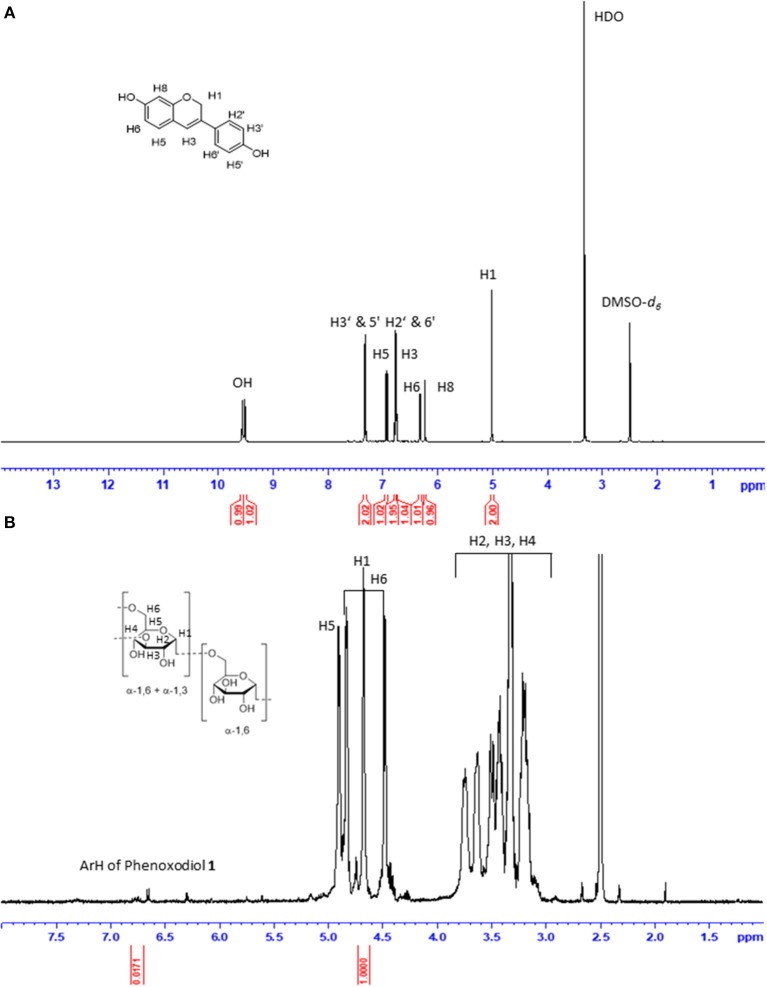
1H NMR spectrum of phenoxodiol 1 (A) and 0.25 mg/ml dextran–phenoxodiol 2 (B) in DMSO-d6.